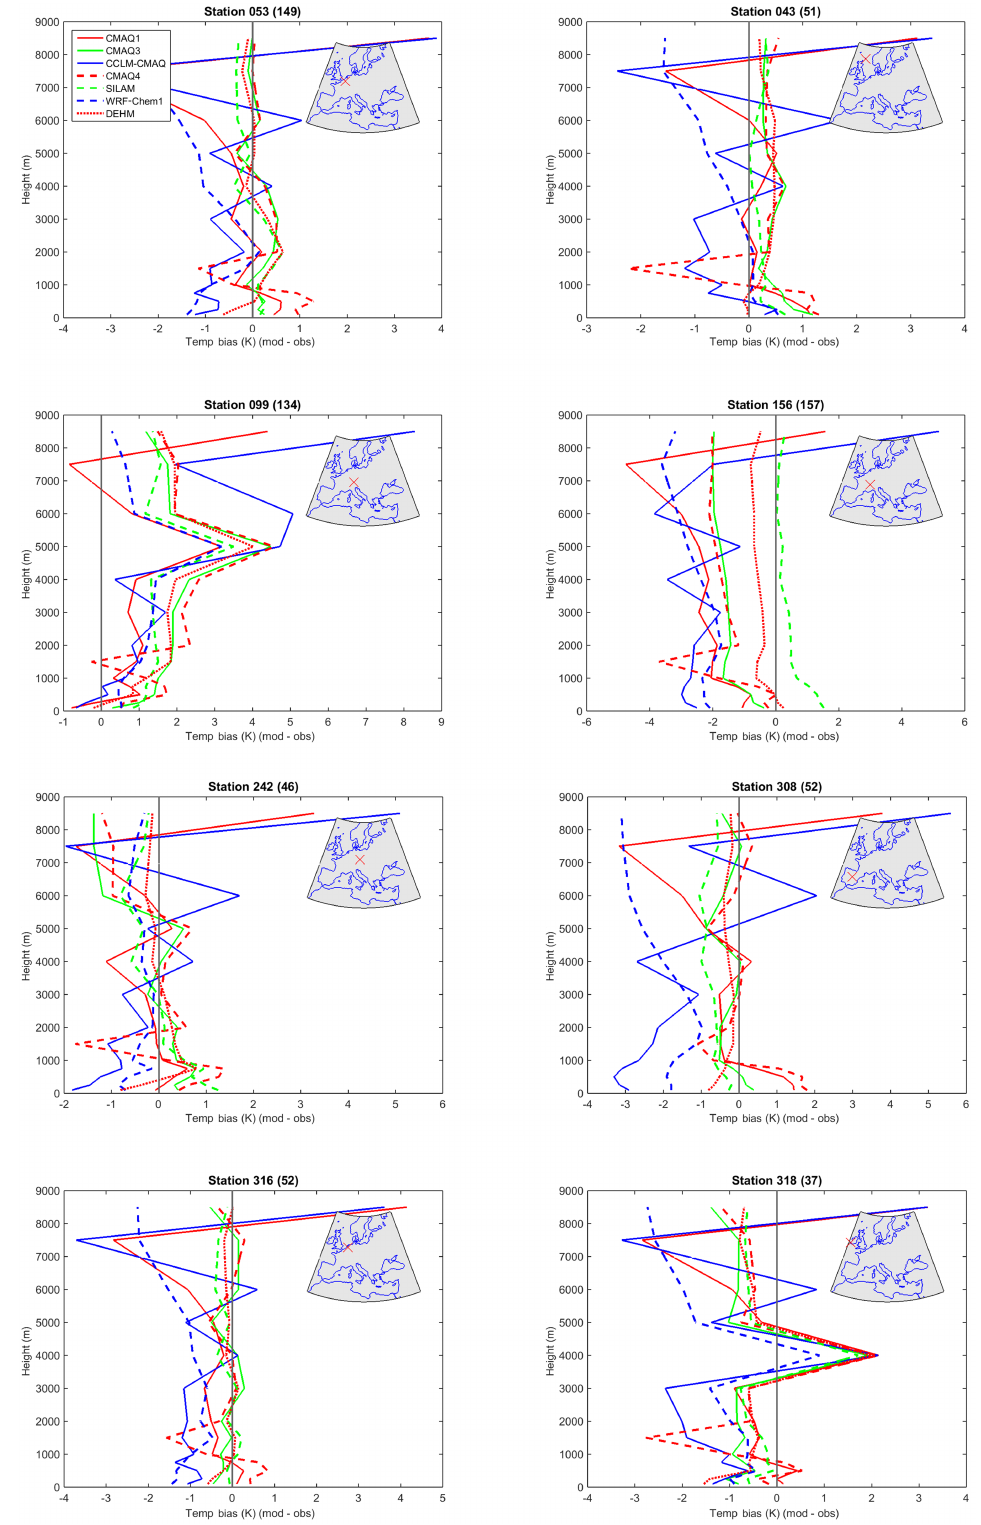
Figure 5. Mean bias (model–observations) for the vertical profiles of temperature measured by ozonesondes launched from the European locations indicated in the inset map of each panel. The number of hourly profiles available for each site is reported in parentheses at the top of each